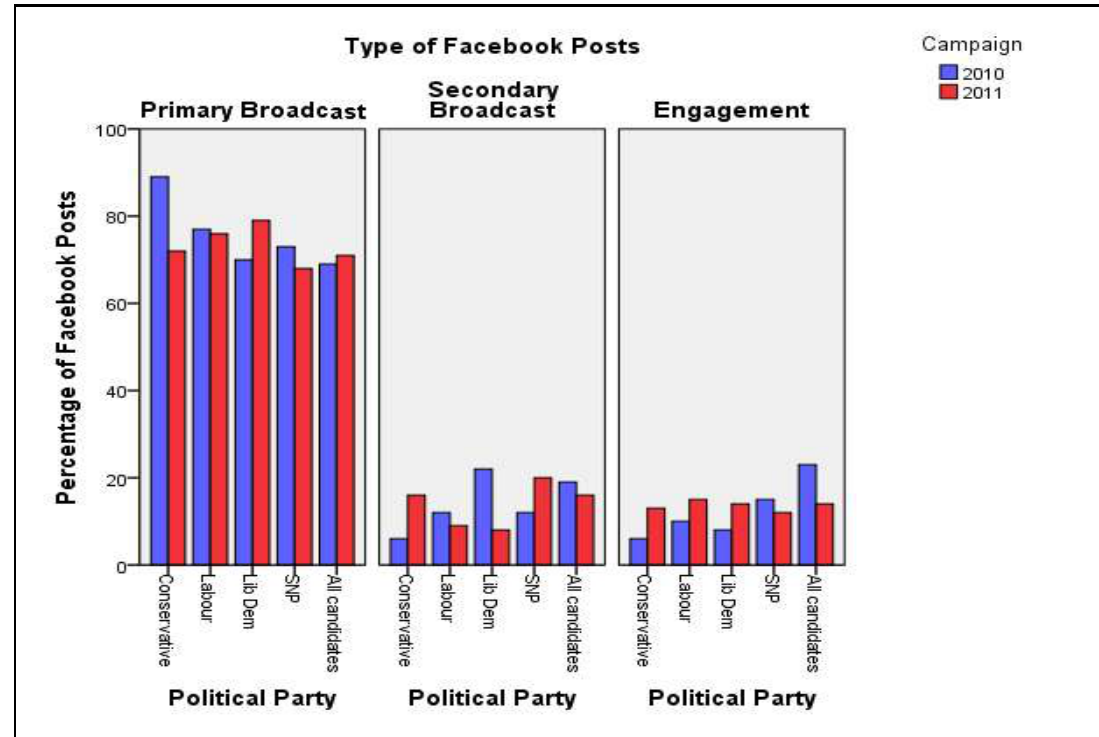
Figure 3: Communicative Nature of Candidates’ Facebook Wall Posts: Comparison of 2010 and 2011